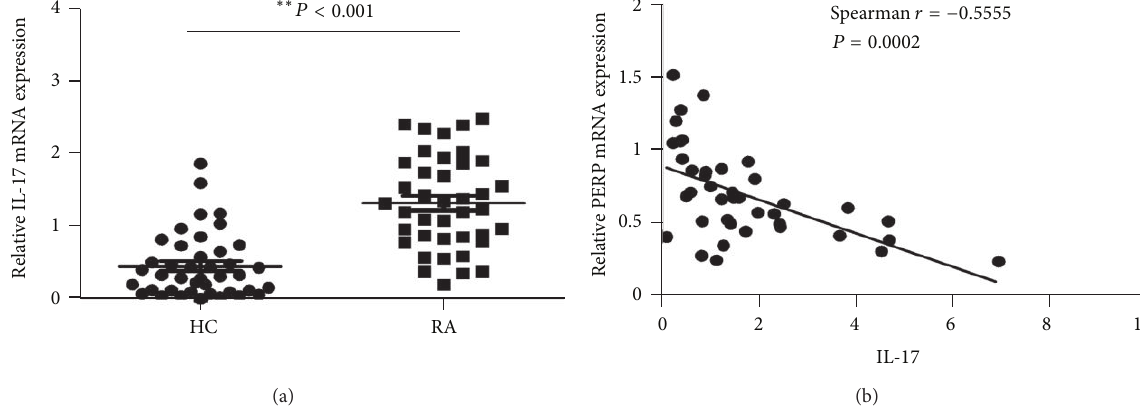
Figure 5: Correlations of PERP and IL-17 mRNA expression levels in RA patients. The mRNA expression levels of patients with RA ( 𝑛 = 40 ) were determined by real-time PCR. (a) The increased expression levels of PERP in patients with RA ( 𝑃 < 0.01 ). (b) There is a significant negative correlation between PERP and IL-17 mRNA expression levels ( 𝑃 < 0.01 ). 𝑃 < 0.05 deems significantly